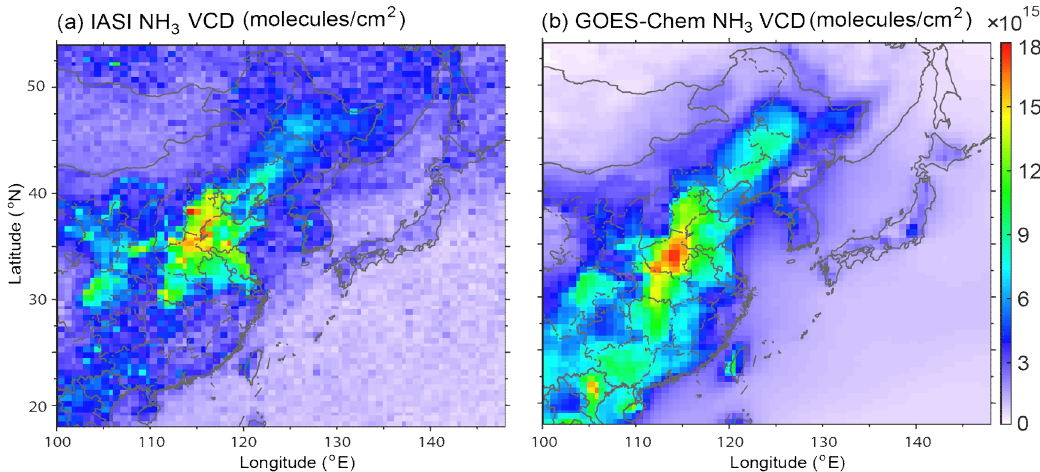
Figure 2. Horizontal distribution of annual averaged ( a ) IASI retrieved and ( b ) GEOS-Chem simulated NH 3 vertical column densities (VCDs) over East Asia for the year of 2014.